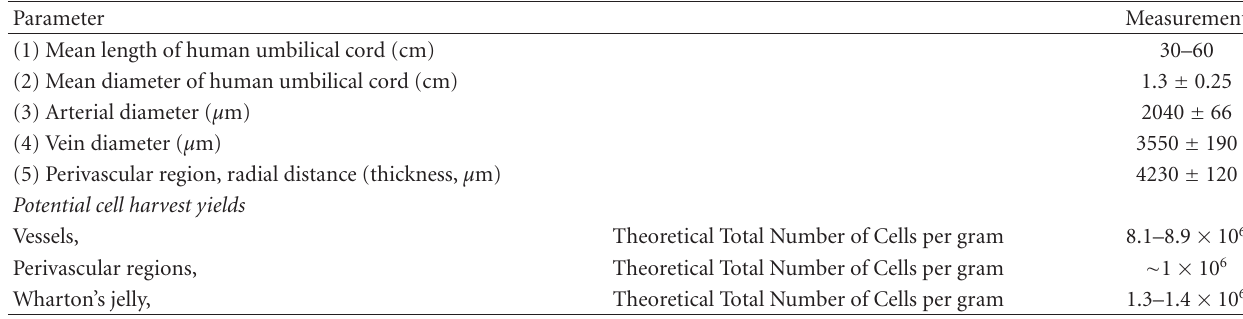
Table 1: Physical properties and cell distributions are used to calculate the theoretical cell numbers in each location. Measurements (mean ± st. dev.) are based on fixed, frozen sections and as shown in Figure 1 and Supplemental